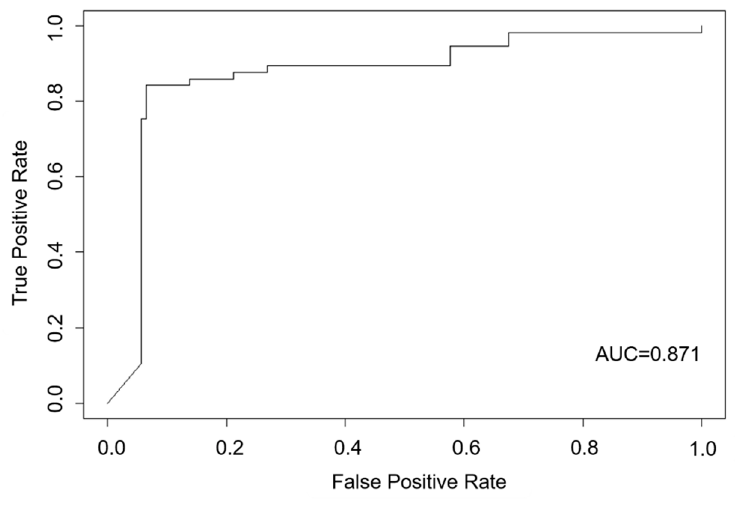
Figure 10. ROC (Receiver Operating Characteristic) and AUC (Area Under the Curve) area of the model.